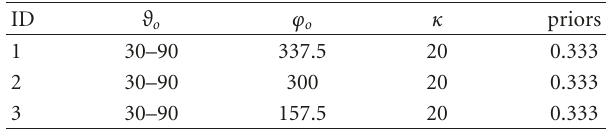
Table 1: Parameters of the VMF mixture density. Note that ele- vation is varied, while the azimuths and concentration parameters have a fixed value.